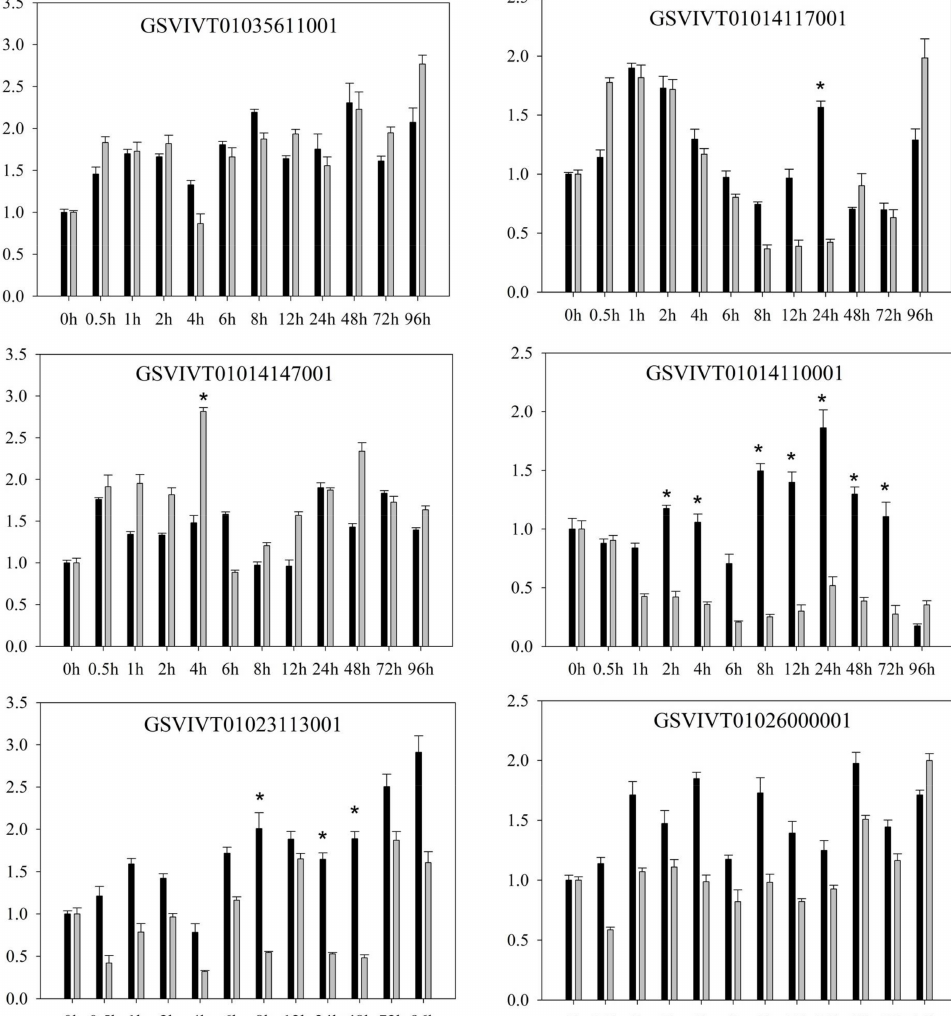
Figure 1. Relative expression of the pattern recognition receptors (PRR) genes of Vitis amurensis “Shuanghong” after inoculation with Plasmopara viticola “ZJ-1-1” (black bars) and P. viticola “JL-7-2” (gray bars). The values on the vertical axes indicate the fold-changes in gene expression normalized to the expression level of Vitis elongation factor 1- α (EF1- α ), SAND, and ubiquitin-conjugating enzyme (UBQ). The x-axes represent the time since inoculation. The error bars represent the standard deviation calculated from three replicates. * indicates significant differences ( p < 0.05) as determined with Student’s t -test. Significant differences were identified by comparing the two gene expression levels at each time